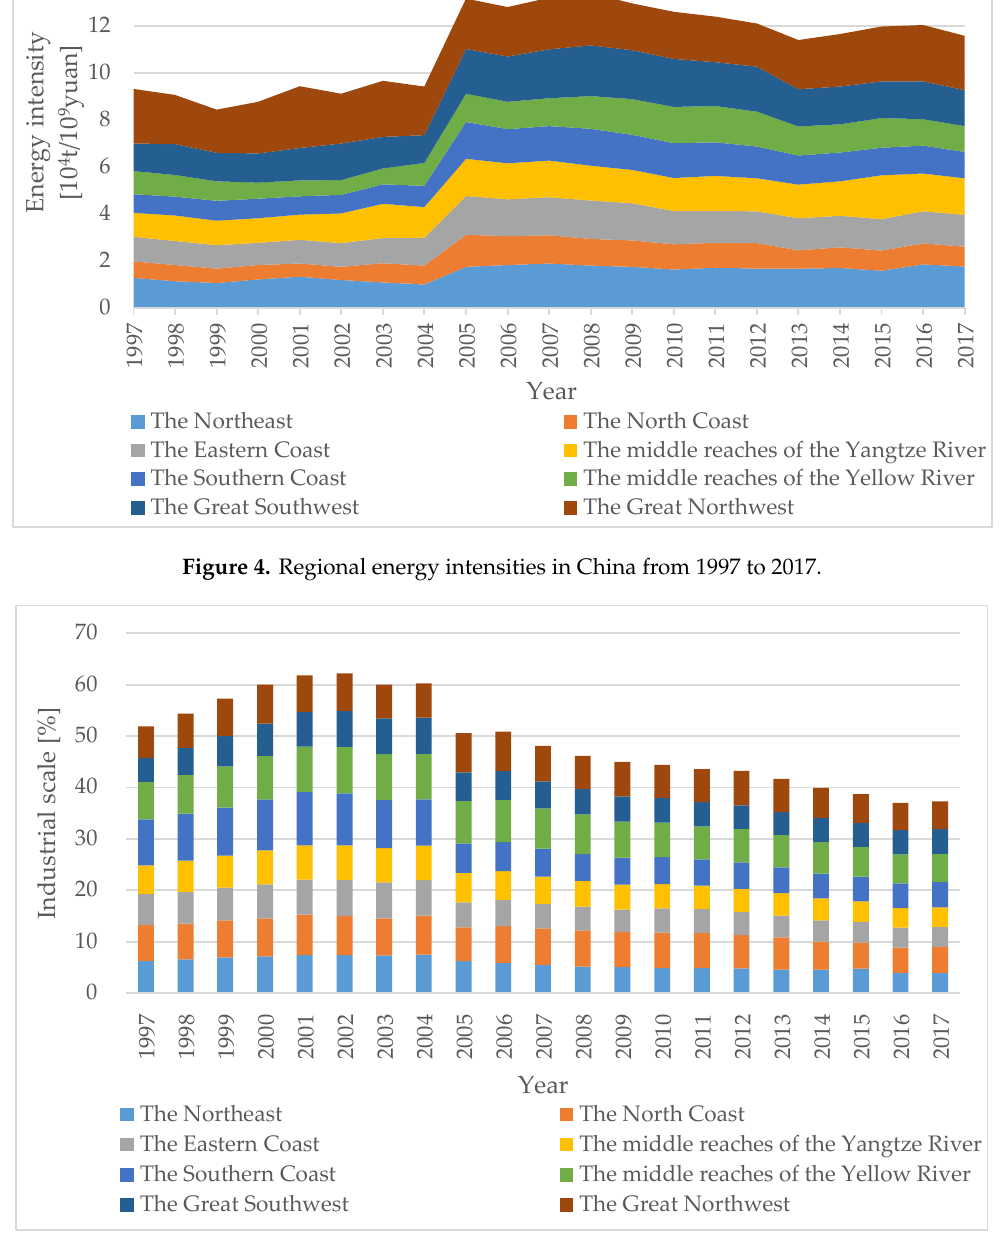
Figure 5. Industry scale in various regions of China from 1997 to 2017.